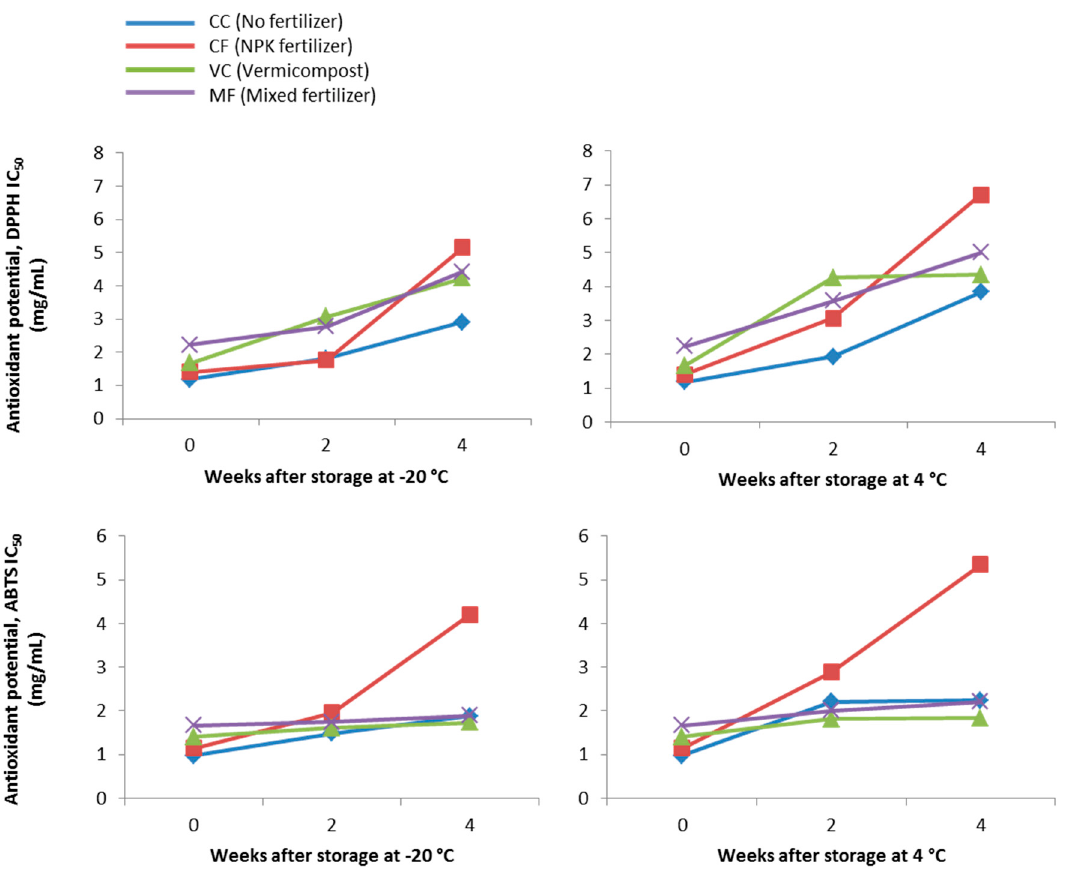
Figure 2. Effect of extract storage at − 20 °C and 4 °C on antioxidant potential of the methanolic extracts of Clinacanthus nutans supplemented with different fertilizers.